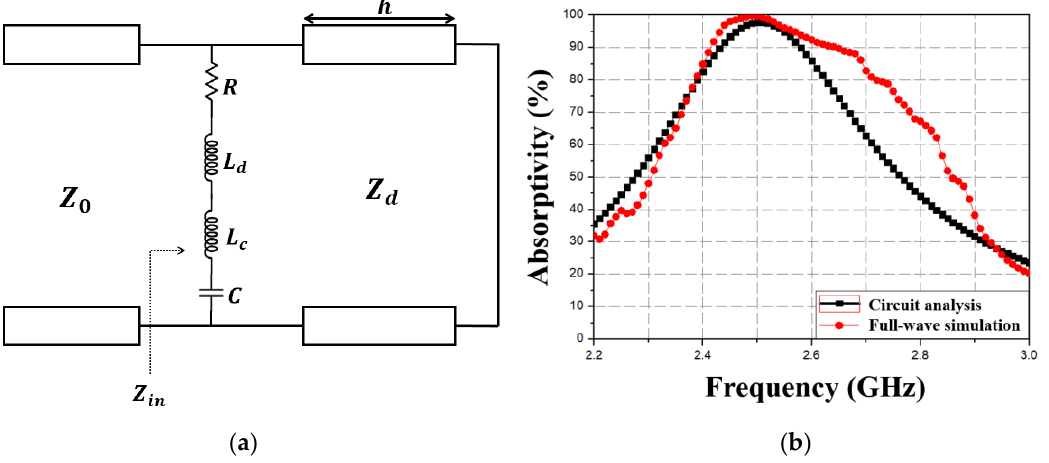
Figure 3. ( a ) Proposed MM absorber equivalent circuit model and ( b ) corresponding simulated absorptivity using full-wave simulation.